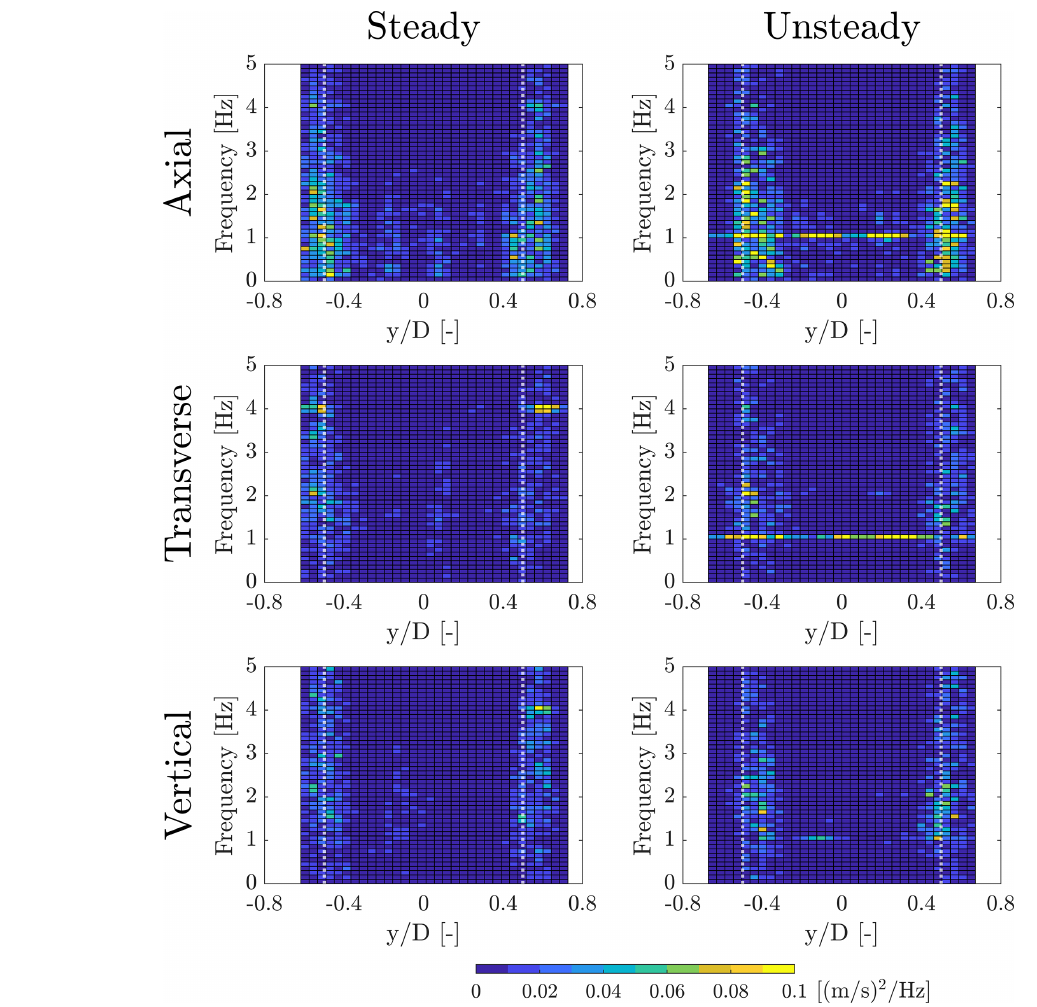
Figure 10. PSD of the hub-height wake velocity components in several cross-wind positions ( y/D = 0 corresponds to the hub location, and rotor edge is marked by the vertical dotted lines) for the RATED2 case. The surge motion of the unsteady case is with f s = 1Hz and A s = 0 .